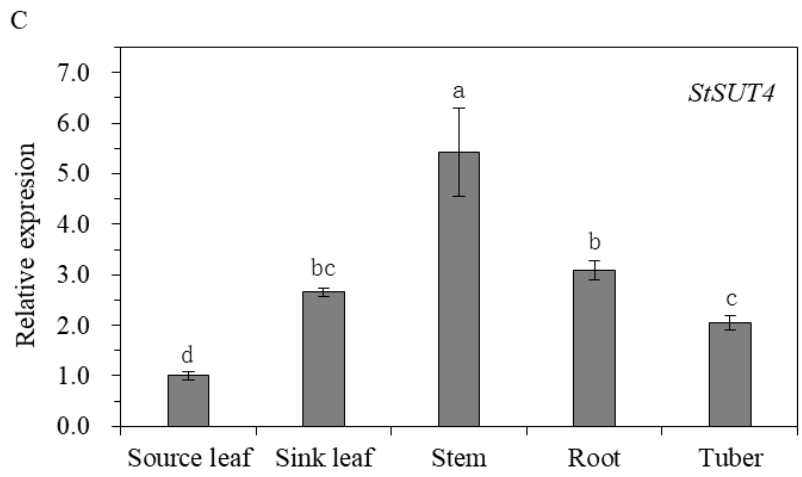
Figure 2. Relative expression of StSUT1 ( A ), StSUT2 ( B ), and StSUT4 ( C ) in different tissues of potato plants by qPCR. According to Duncan’s multiple range test, the same letters are not significantly different at p ≤ 0.05.